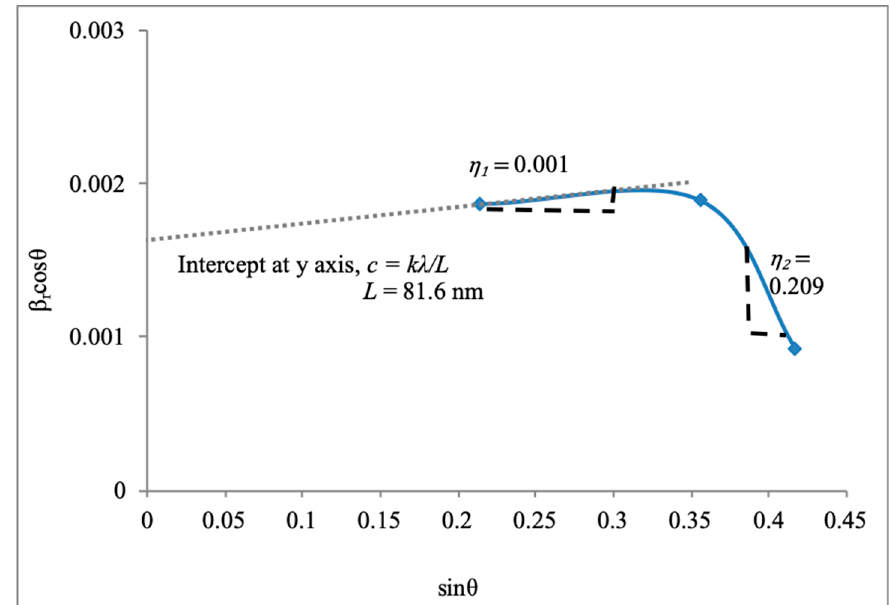
Figure 7. Plot of β r cos θ versus sin θ from XRD data of the 1 min sample.